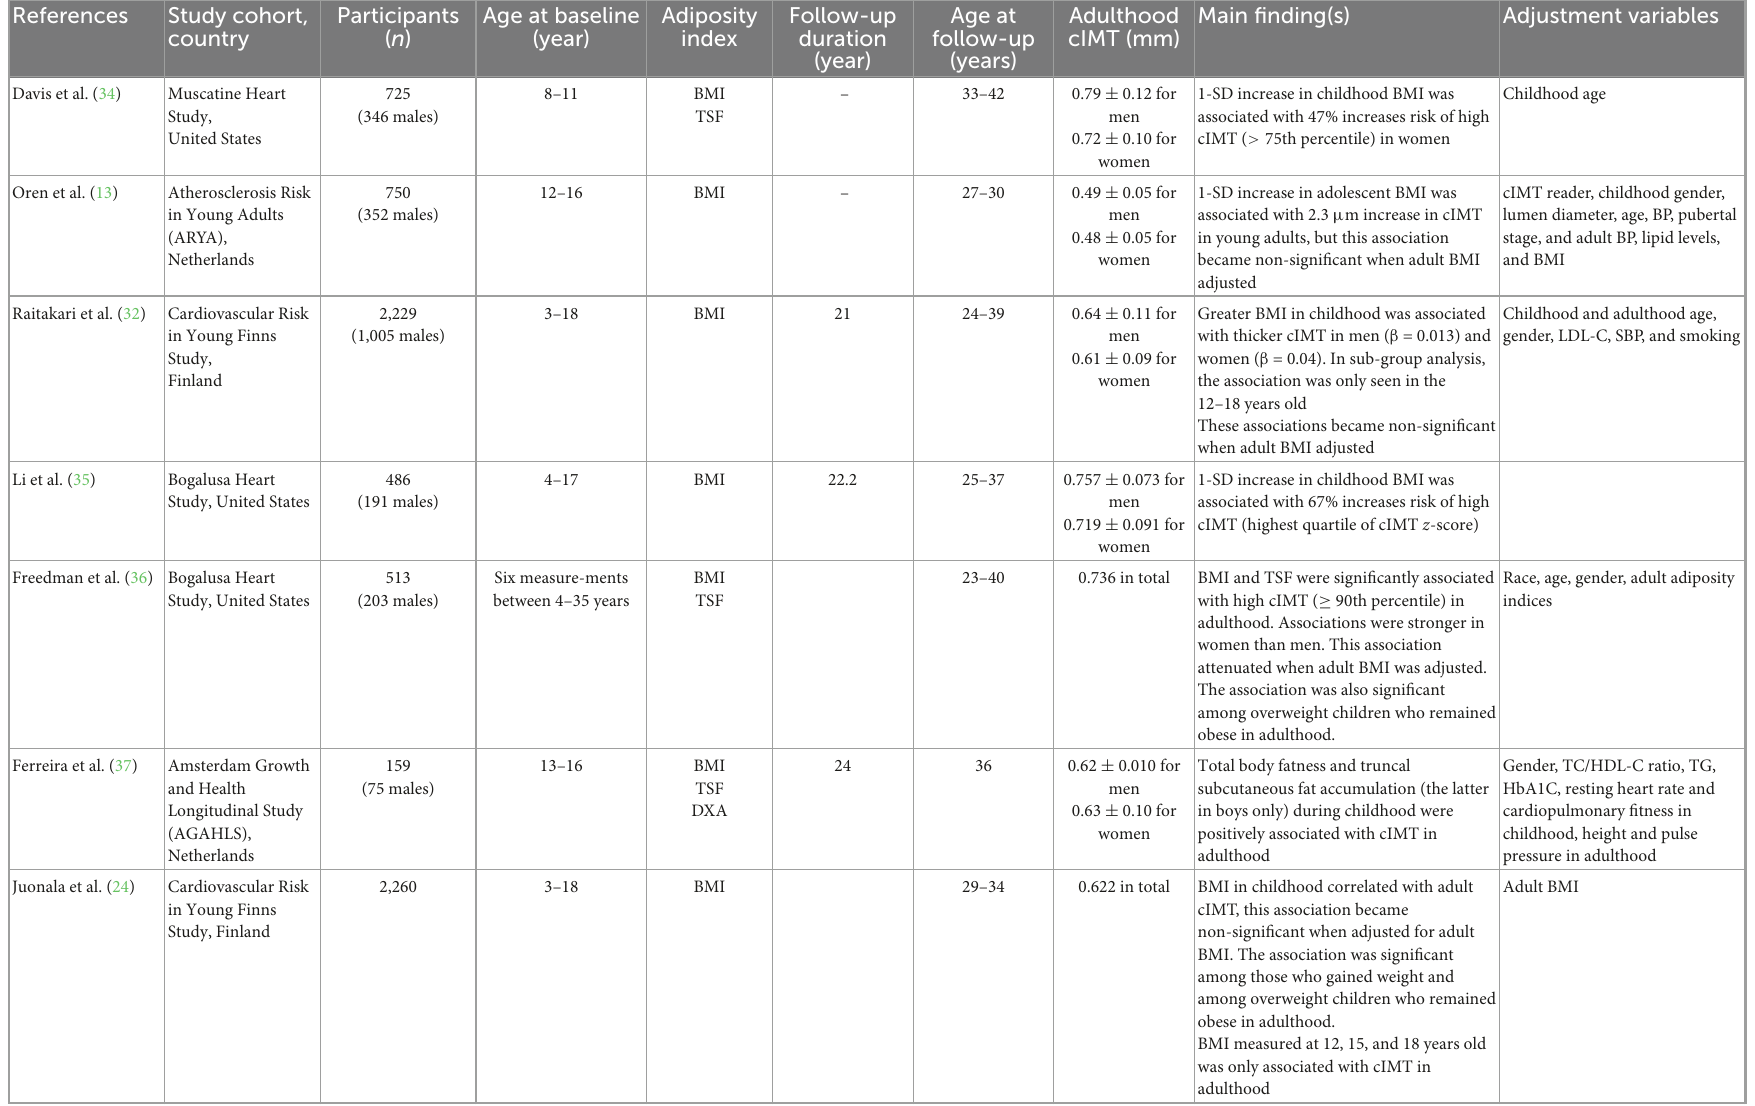
TABLE 3 Description of papers that evaluated the association between childhood adiposity and carotid intima-media thickness (cIMT) in